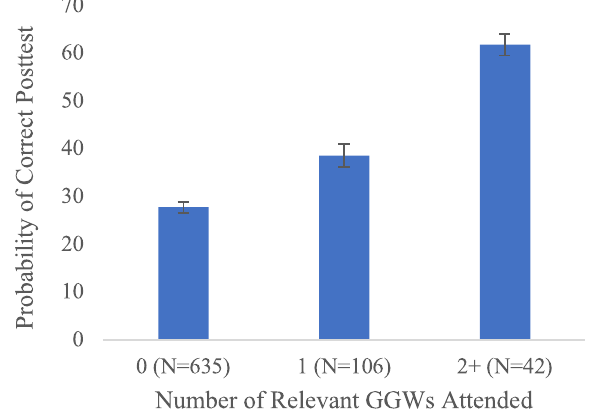
FIG. 4. Probability of correctly answering a binary (right or wrong) item on the post-test, given that students answered incorrectly on the pretest. Results are averaged over different students and items, and are separated by the number of item- relevant GGW treatments students received. N is the number of student items in each category. Error bars represent standard error, although there are correlations within the data.